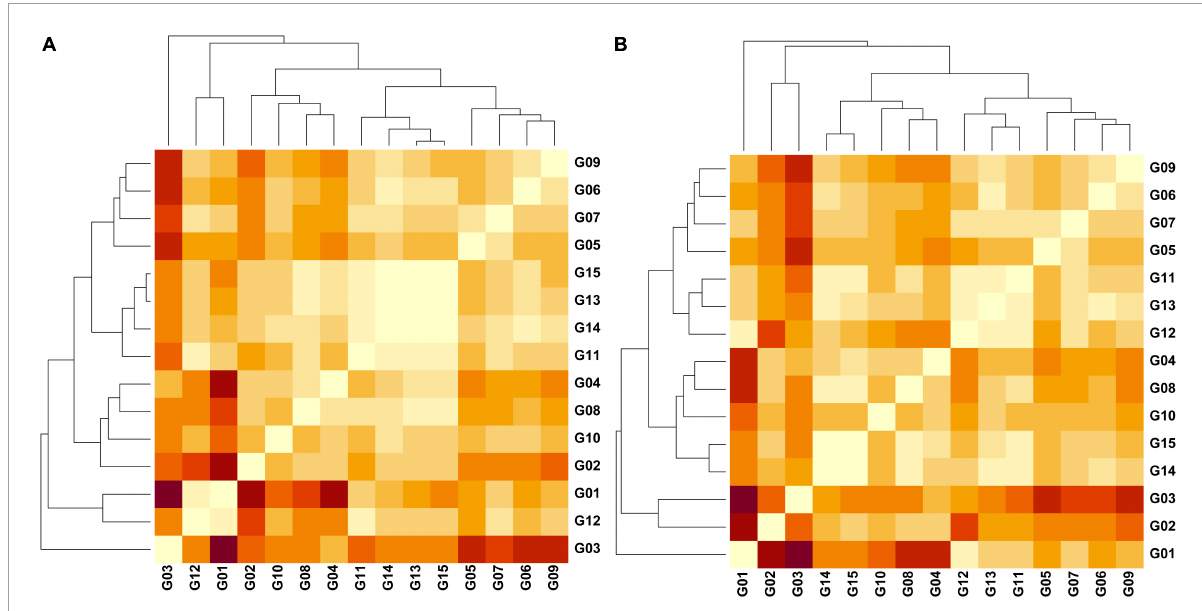
FIGURE4 Heatmaps representing pairwise Jost differentiation indices (D est ) (light = 0.00/dark = 0.626) among 15 groups of cacao samples based on the genetic variation of 136 SNPs examining (A) three regions and (B) three phylogenetic clusters in north Peru. Groups – G1 (Amelonado; n = 40), G2 (Contamana; n = 8), G3 (Criollo; n = 12), G4 (Curaray; n = 17), G5 (Guiana; n = 56), G6 (Iquitos; n = 32), G7 (Marañon; n = 70), G8 (Nacional; n = 40), G9 (Nanay; n = 60), G10 (Purús; n = 5), G11 (Amelonado/Nacional; n = 25), G12 (Amelonado/Criollo; n = 25), G13 A (Bagua; n = 16), G14 A (Condorcanqui; n = 24), G15 A (Utcubamba; n = 91), G13 B (PhyloA; n = 14), G14 B (PhyloB; n = 33), G15 B (PhyloC; n = 64). D est values obtained in GenAlEx v6.502 (Peakall and Smouse, 2006,